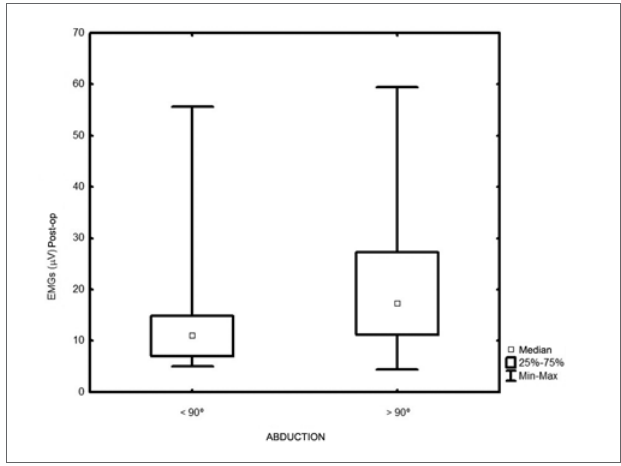
Figure 3. Electromyography in relation to the arm movement. - p